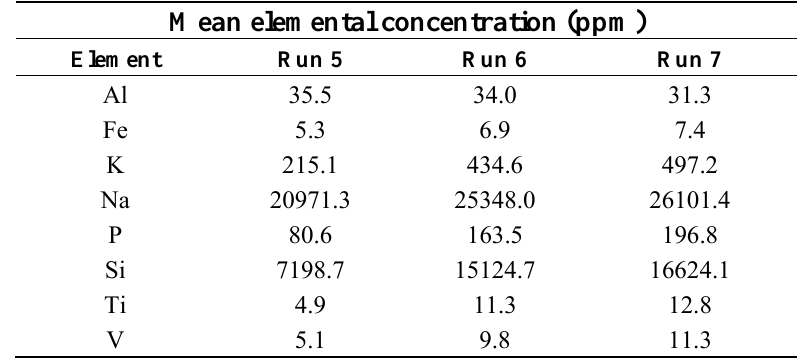
Table 2. Atomic emission spectrometry results indicating elemental concentrations of major species found in the waste supernatant after each successive